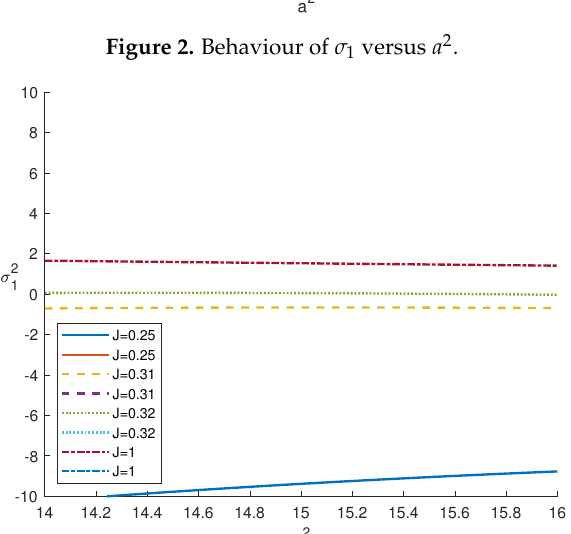
Figure 2. Behaviour of σ 1 versus a 2 .